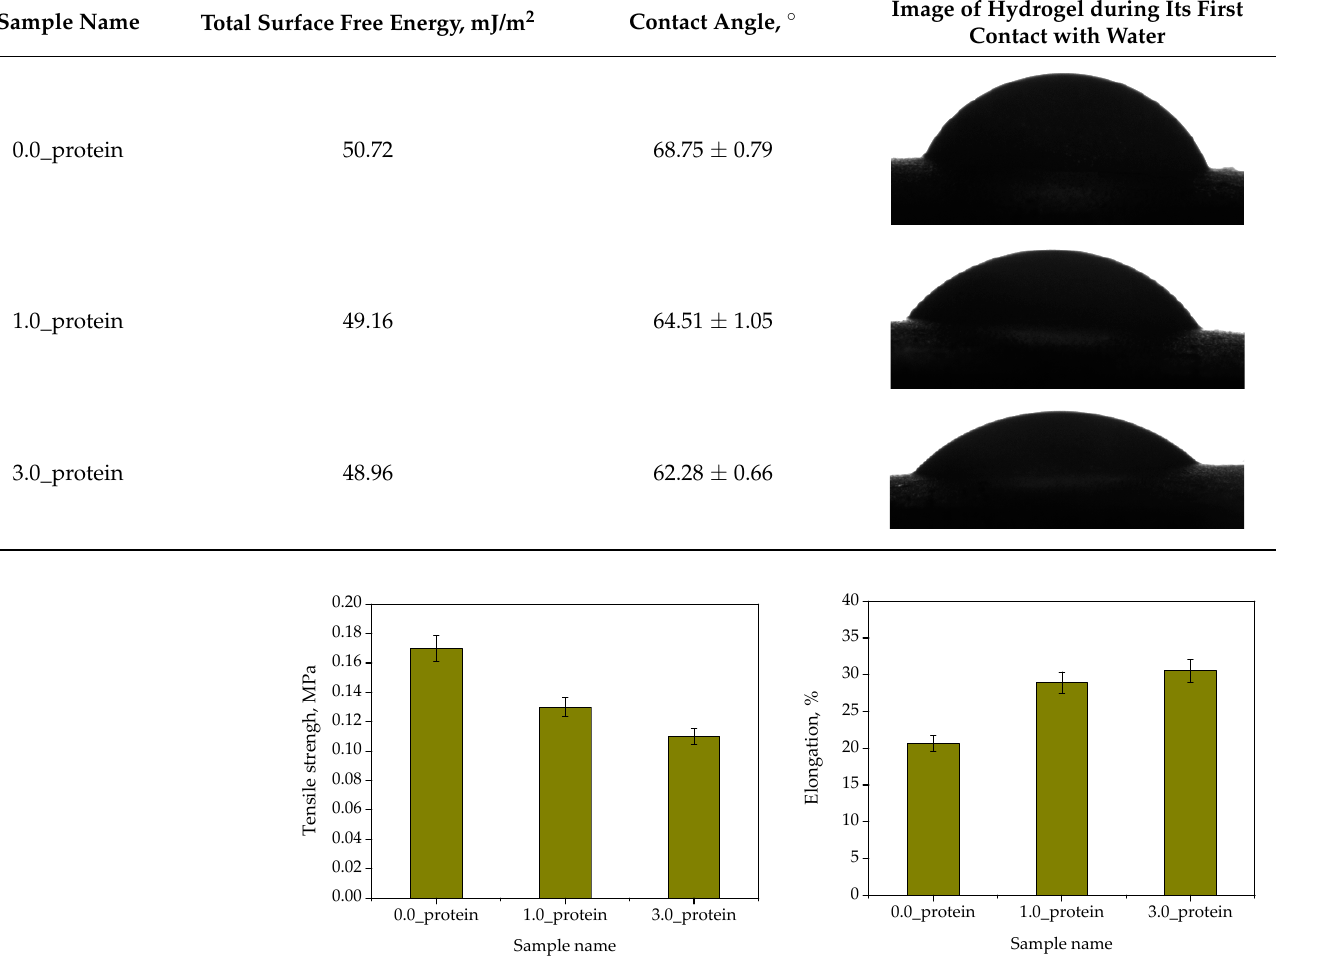
Table 1. Results of hydrogels’ wettability analysis.